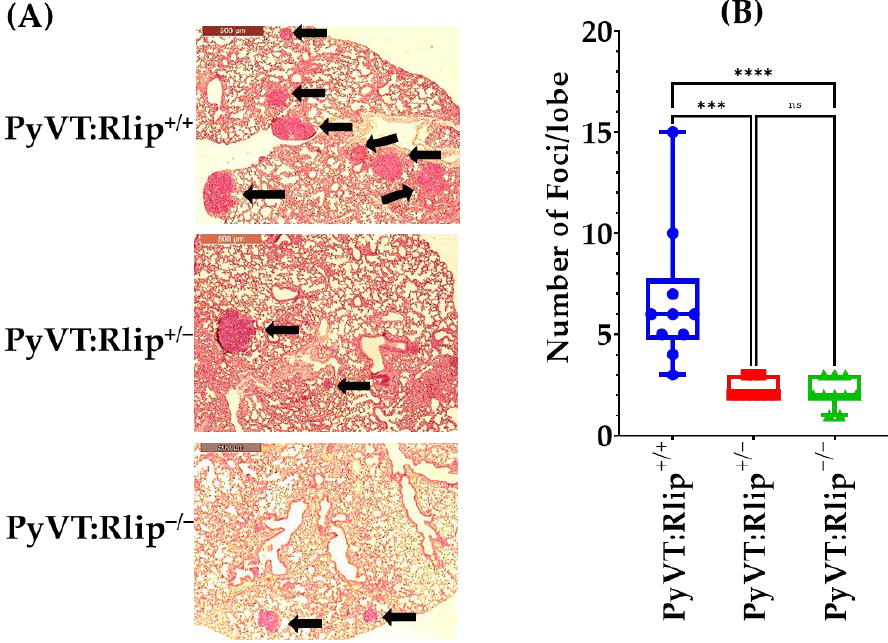
Figure 5. Rlip knockout reduced tumor lung metastases in PyVT:Rlip −/− and PyVT:Rlip +/− mice. ( A ) Low-magnification (40×) H&E-stained images of lungs showing tumor metastases (arrows) in approximately 140–150 day old female PyVT:Rlip +/+ , PyVT:Rlip −/− , and PyVT:Rlip +/− mice. ( B ) Number of metastatic foci in lung of PyVT:Rlip +/+ , PyVT:Rlip −/− , and PyVT:Rlip +/− mice. Foci were counted in a blinded fashion and values are presented as means ± SD ( n = 5 each group); ns = not significant; *** = p < 0.001 and **** = p < 0.0001.